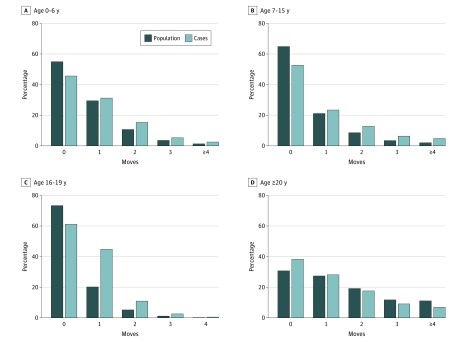
Residential Mobility by Number of Moves and Outcome Status by Age PeriodAt ages 0 to 6 (A), 7 to 15 (B), and 16 to 19 years (C) the proportion of cases who moved once or more was greater than in the population at risk. By contrast, at 20 years and older (D), case participants were more likely to have never moved than the population at risk. Percentages in the 20 years or older group were estimated from participants who were not censored before this age (n = 998 967 [69.9%]). Percentages at all other age ranges were based on the full sample (N = 1 440 383). At age 16 to 19 years, the maximum number of possible moves during this period is 4.